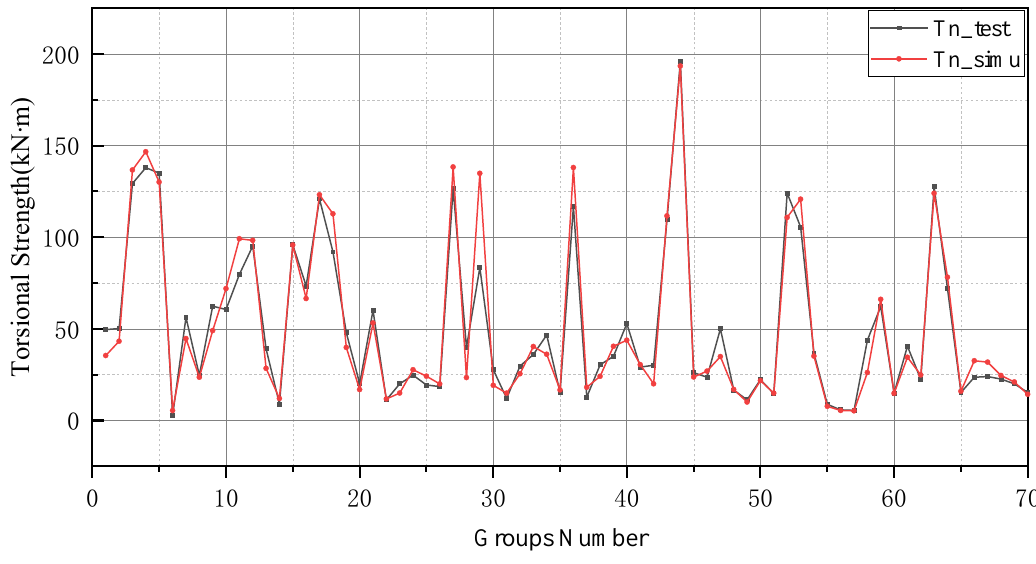
Figure 11. GA-BP neural network optimized by k-fold cross-validation.